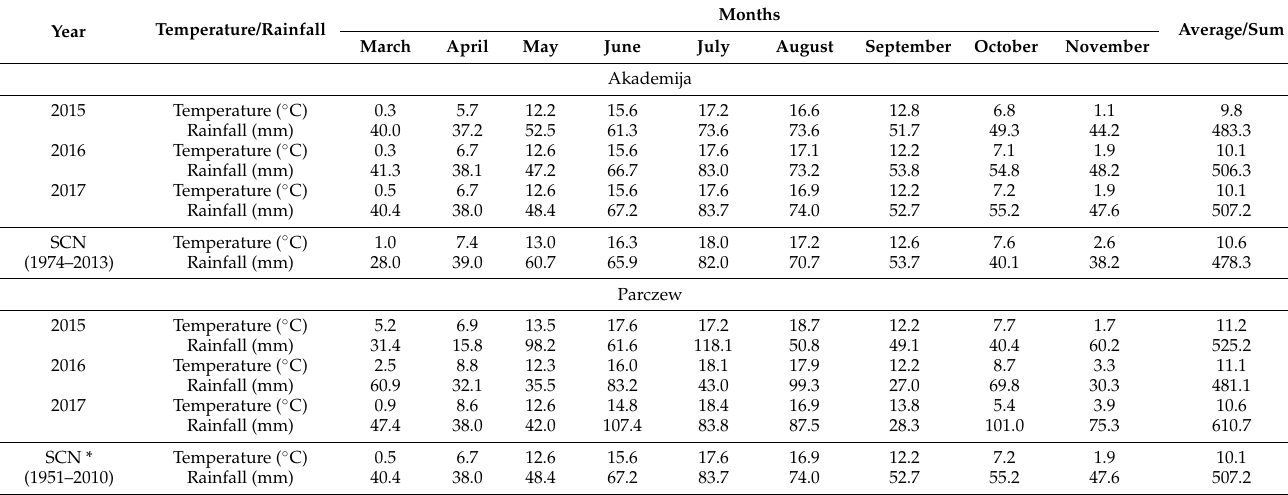
Table 2. The course of air and rainfall temperatures (2015–2017) obtained from the meteorological station in Akademija (Lithuania) and Parczew (Poland).